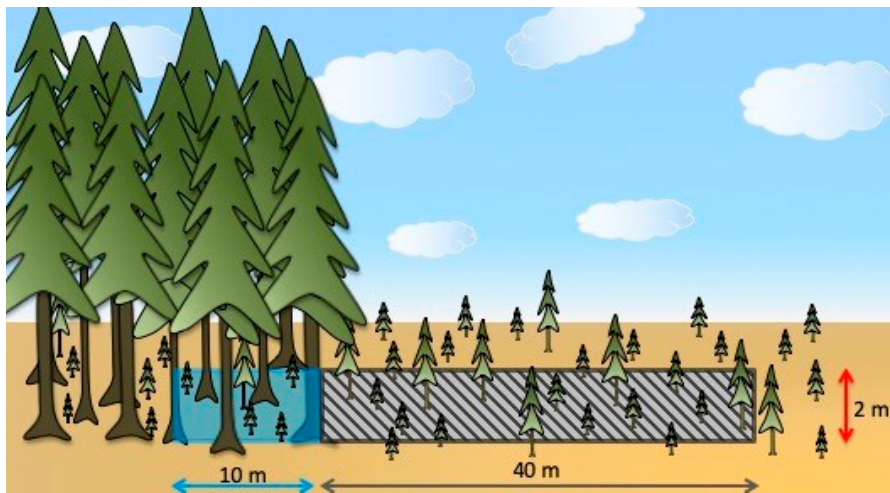
Figure 2. Schematic representation of a sampling plot where the blue rectangle corresponds to the residual stand area (20 m 2 ), and the grey rectangle represents the harvested area (80 m 2 ).